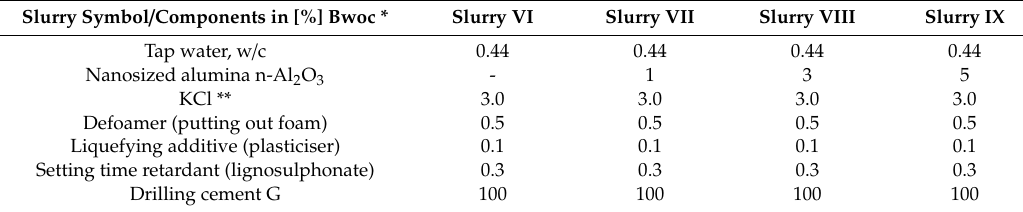
Table 6. Compositions of tested cement slurries with an addition of n-Al 2 O 3 . Slurry Symbol / Components in [%] Bwoc